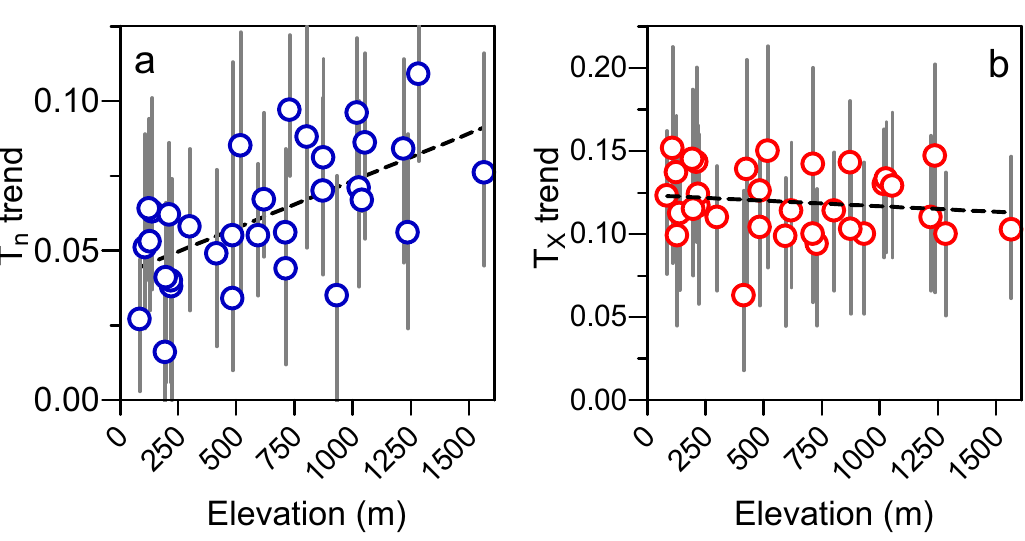
Figure 3. Linear warming trends observed on ( a ) mean minimal (blue circle ± 95% CI) and ( b ) maximal (red circle ± 95% CI) April to June temperatures (°C year −1 ) and elevation (m asl) for the 32 studied